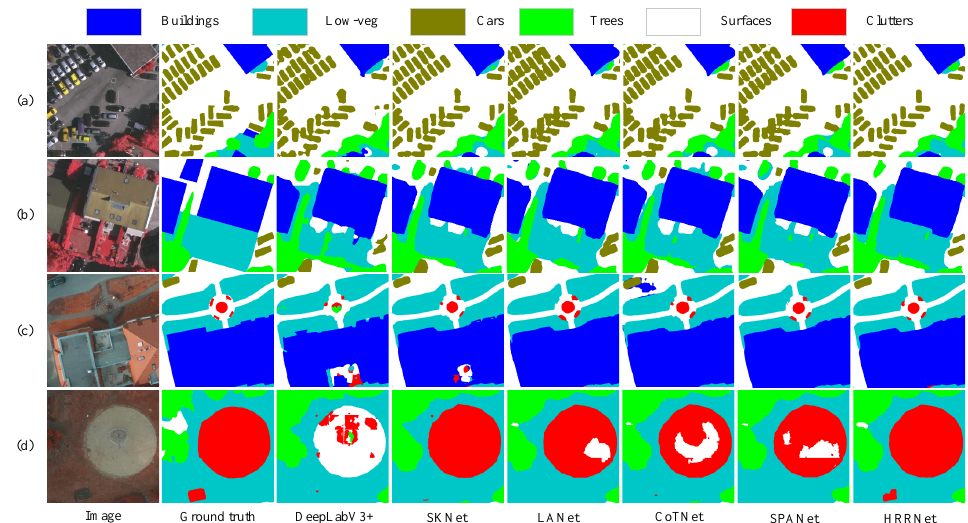
Figure 6. Visual segmentation maps for various models. Rows ( a , b ) are the results of cropping on the Vaihingen dataset. Rows ( c , d ) are the results of cropping on the Potsdam dataset.